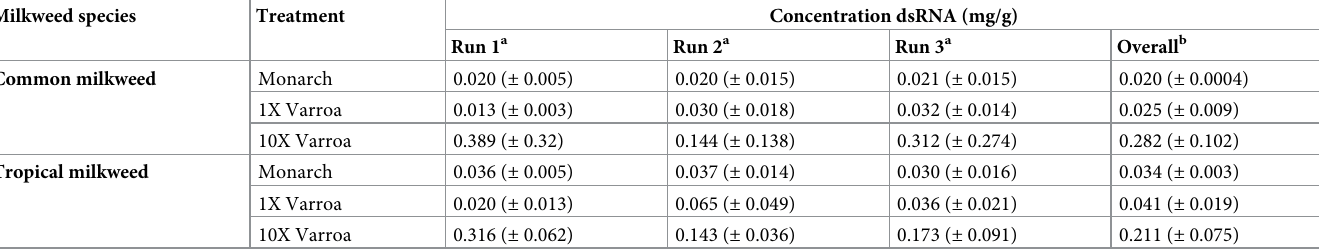
Table 1. The mean concentration measured for each treatment group and the overall